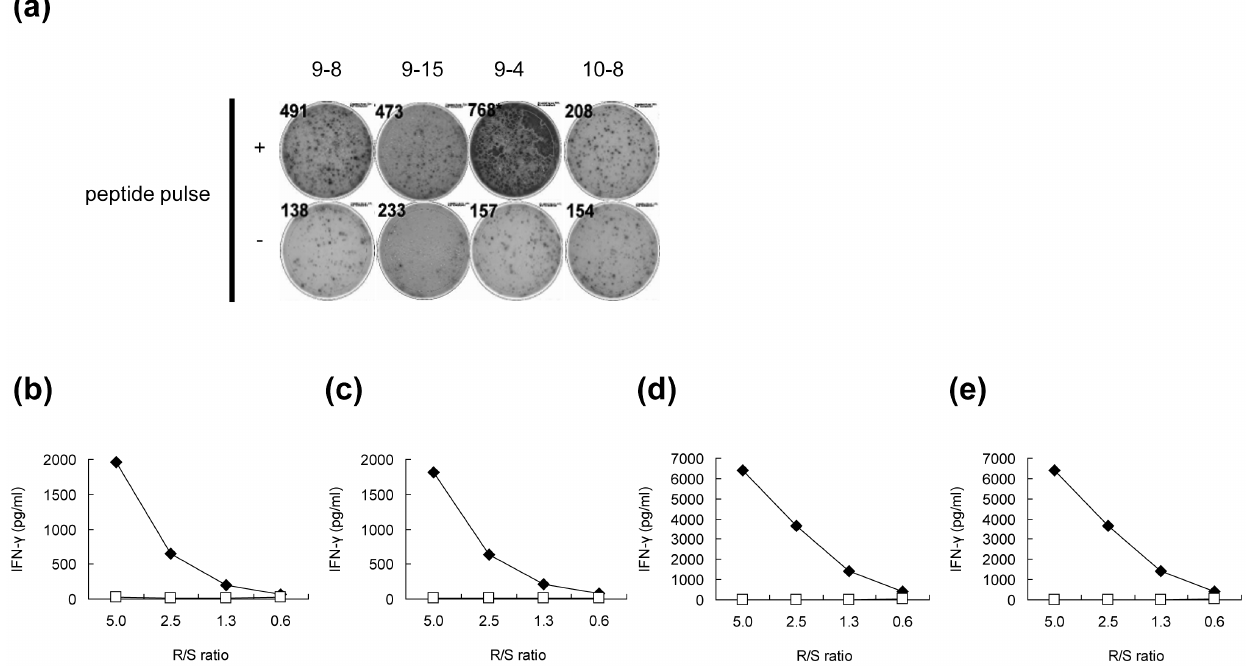
Figure 1. The IFN- c production in response to the HIG2-9-8, HIG2-9-15, HIG2-9-4 or HIG2-10-8 peptide. (a) The IFN- c production from cells induced by the indicated peptide-pulsed DCs was examined by an ELISPOT assay using T2 cells. ‘‘ + ’’ indicates the wells in which cells were stimulated with T2 cells pulsed with the indicated peptide and ‘‘ 2 ’’ indicates the wells in which cells were stimulated with HIV peptide-pulsed T2 cells. The IFN- c production from cells induced with HIG2-9-8 (b), HIG2-9-15 (c), HIG2-9-4 (d) or HIG2-10-8 (e) peptide stimulation after CTL expanding culture was examined by ELISA. Cells were stimulated with T2 cells pulsed with the corresponding peptide (closed diamonds) or HIV peptide (open squares) at the indicated responder/stimulator ratio (R/S ratio). Similar results were obtained from three independent experiments. doi:10.1371/journal.pone.0085267.g001 day 10 (final concentration: 125 IU/ml). On day 14, an IFN- c round bottom plates (Corning, Inc.), and were cultured with ELISPOT assay was performed to measure the CTL activity of MMC-treated 1 6 10 4 Jiyoye and EB-3 cells in 125 m l AIM-V containing 5% AB serum and 30 ng/ml of an anti-CD3 each clone. monoclonal antibody on day 0. IL-2 was added to each well on